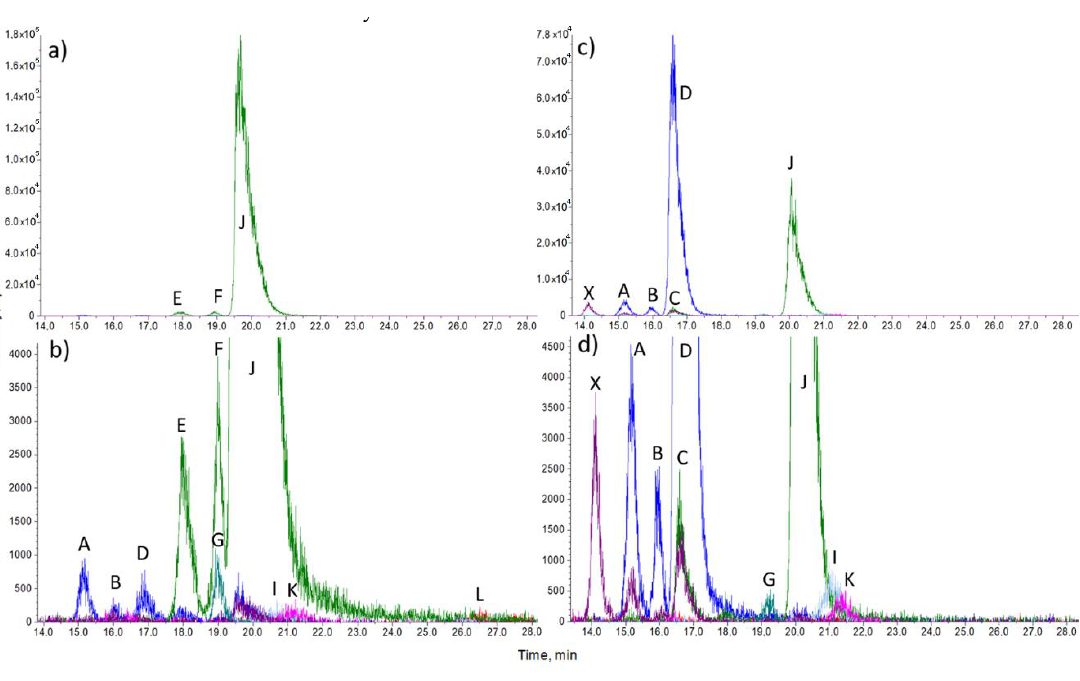
Figure 2. Representative chromatograms of sterols isolated from native HepG2 cells ( a , b ) and HepG2 DHCR KO cells ( c , d ). Each chromatogram is presented in two magnifications to account for a higher quantity of cholesterol compared to intermediate sterols ( a , b ) or desmosterol and cholesterol compared to other sterols ( c , d ). Zymosterol (A), 24-dehydrolathosterol (B), 7-dehydrodesmosterol (C), 7-desmosterol (D), zymostenol (E), F-lathosterol (F), lathosterol-d7 (G), TMAS (I), holesterol (J), lanosterol (K), dihydrolanosterol (L), and an unknown peak with the MRM of 365 / 199 (X). All peaks with the same MRM transition (A, B, D and E, F, J) are chromatographically separated. Peak of cholesterol is depicted for illustrative purpose only.